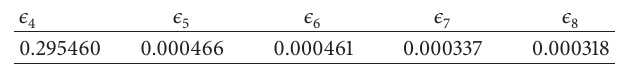
1 |𝑓 ∗ (𝑥) − 𝑓 ∗ (𝑥)| 2 𝑑𝑥 of Example 6 for 𝑁 = 𝑁 𝑁+1 0